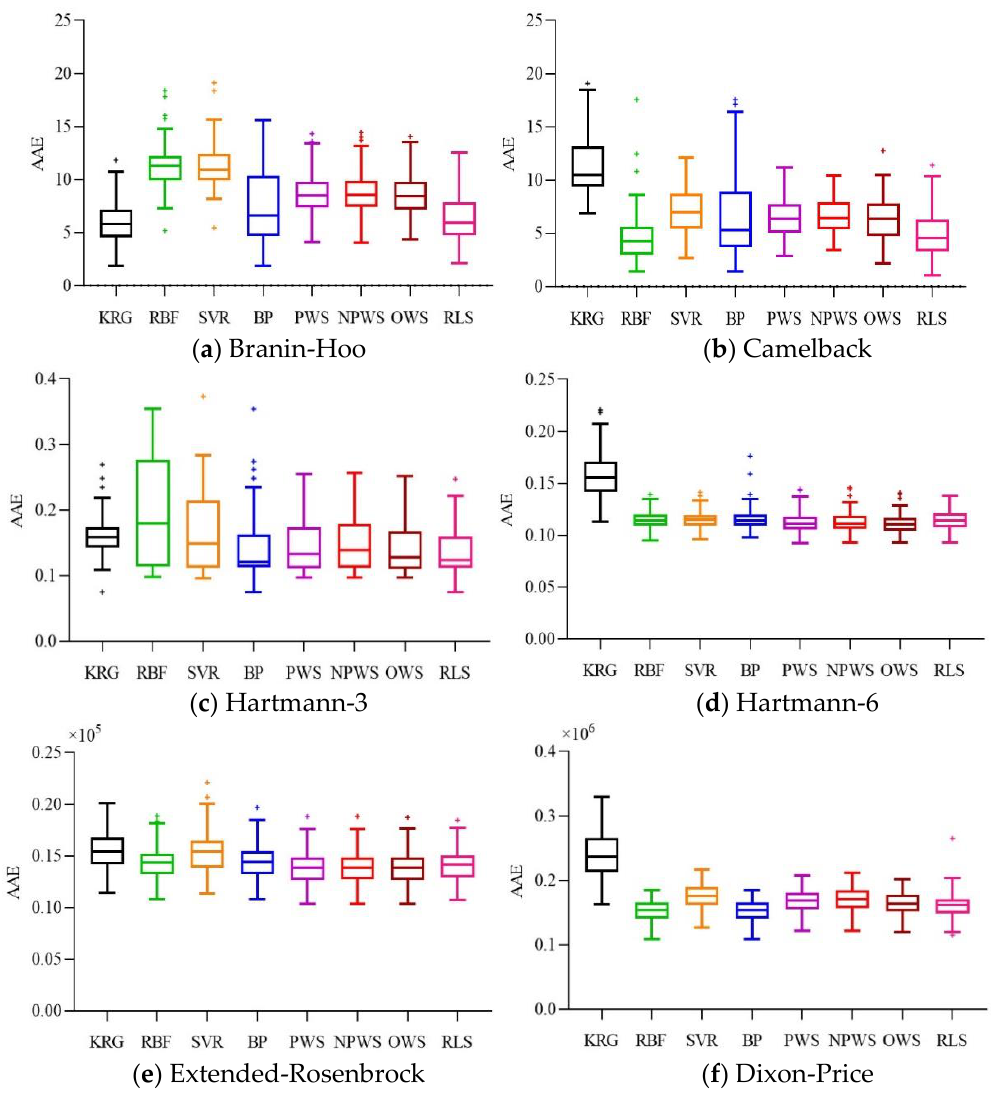
Figure 4. Boxplots of AAE for the six numerical examples.